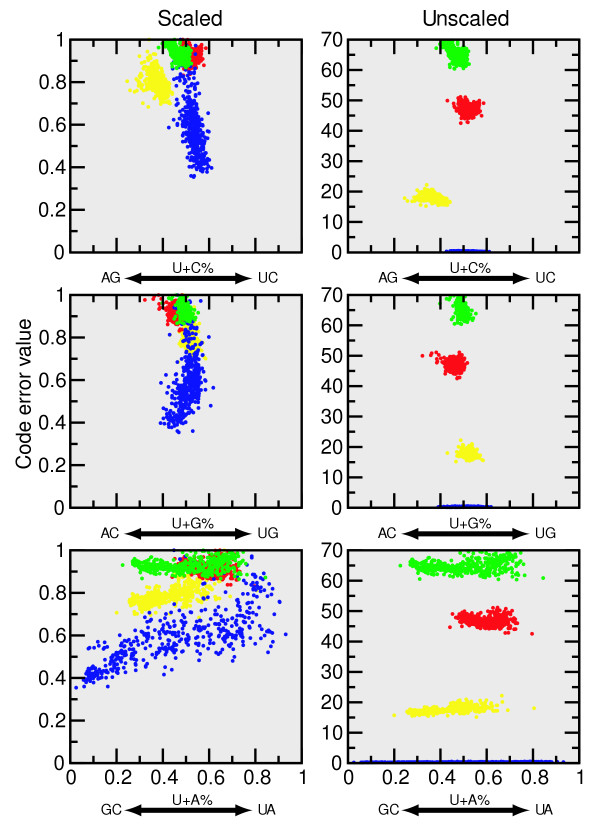
Variation in code error along the three axes in composition space: G+A, G+C, G+U. Scatterplots of variation in code-error value along each of the three axes that make up the composition space. Top row, UC content; middle row, UG content; bottom row, UA content. Left column, error value at each codon position individually scaled relative to the maximum value for that position (maximum = 1.0). Right column, absolute error values for each codon position. First position, yellow; second position, red; third position, blue; and total, green. Data shown are for bacteria, though results were similar for the other two domains (data not shown). Although substantial correlations are revealed in the scaled data, these correlations contribute little to the overall error value, which is dominated by the second codon position.